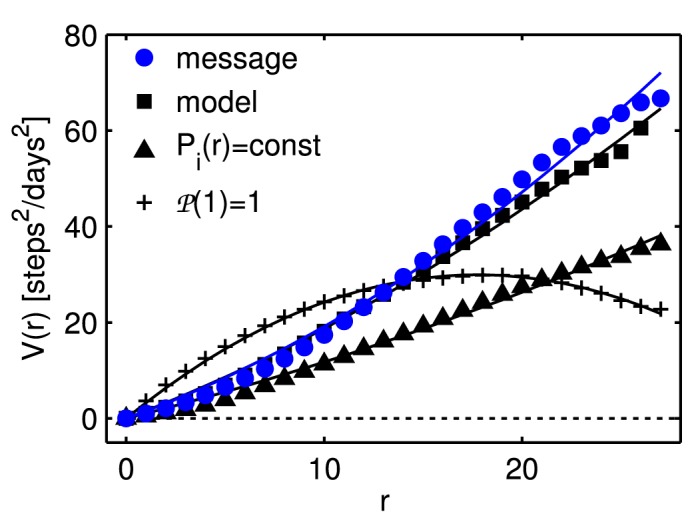
Interaction potential derived from the random walker model.The interaction potential derived from the random walker model (squares) reproduces to a large extent the empirical potential for messages (blue circles). The model uses the actual topology of the universe and assumes an attractive acceleration that is conditional on interaction but independent of the distance. Triangles show the situation where the distance-dependent interaction probabilities are set to be constant, (+) represent an unrealistic constant jump-distance distribution of one step per time. Lines are least-squares fits to harmonic potentials as in Eq (4).